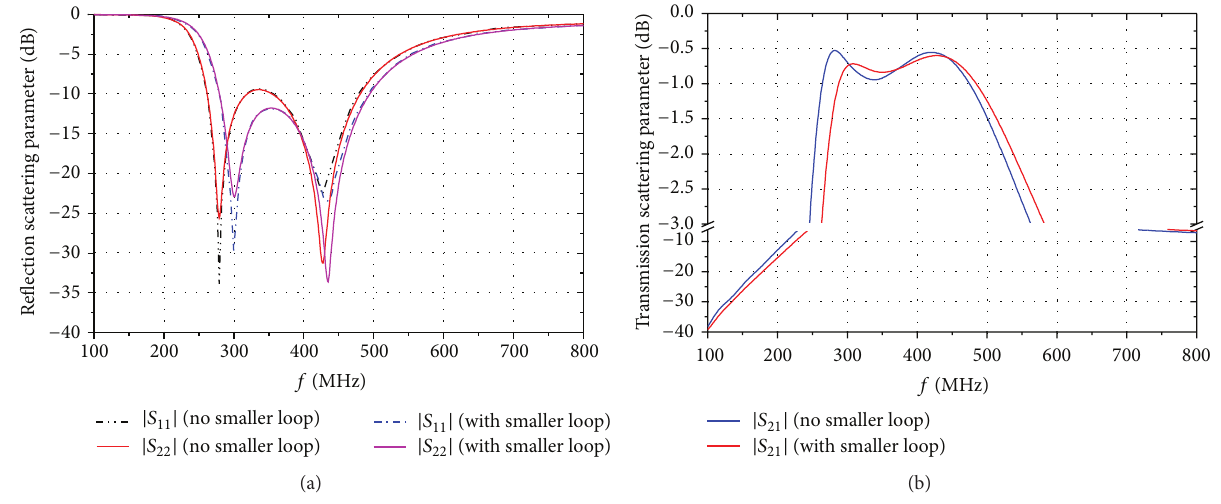
Figure 5: Comparison between the scattering parameters, calculated by means of full-wave simulations, for the proposed wireless energy link, obtained with and without the smaller loop: (a) reflection scattering parameters; (b) transmission scattering parameters.